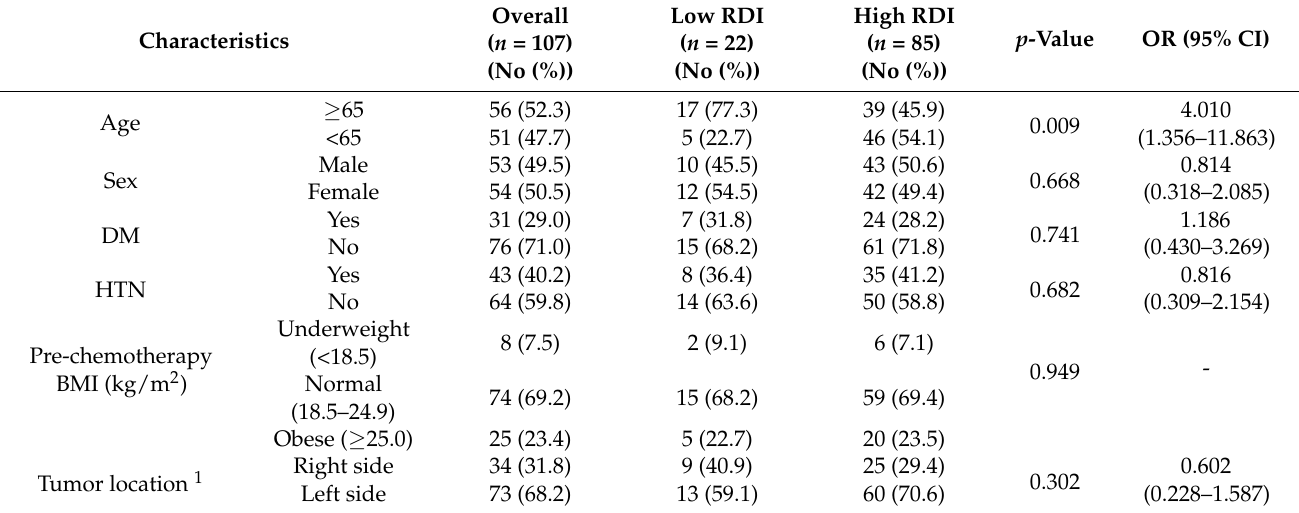
Table 1. Baseline characteristics of patients with stage III CRC who underwent FOLFOX